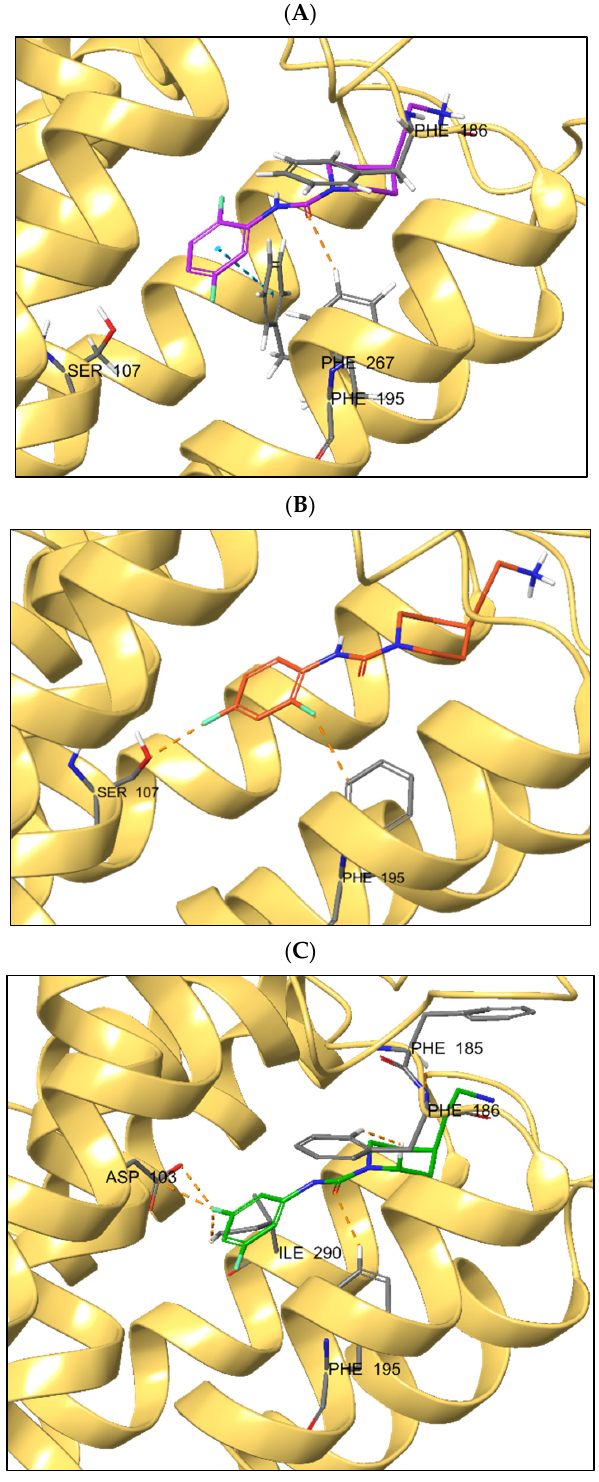
Figure 5. ( A ) Unconstrained docking pose of compound 12 ; ( B ) forcibly docked compound 13 with the clash with Ser107 residue; ( C ) forcibly docked compound 14 with a network of unfavorable clashes. Dashed lines of orange and red color—strained protein–ligand contacts (clashes).